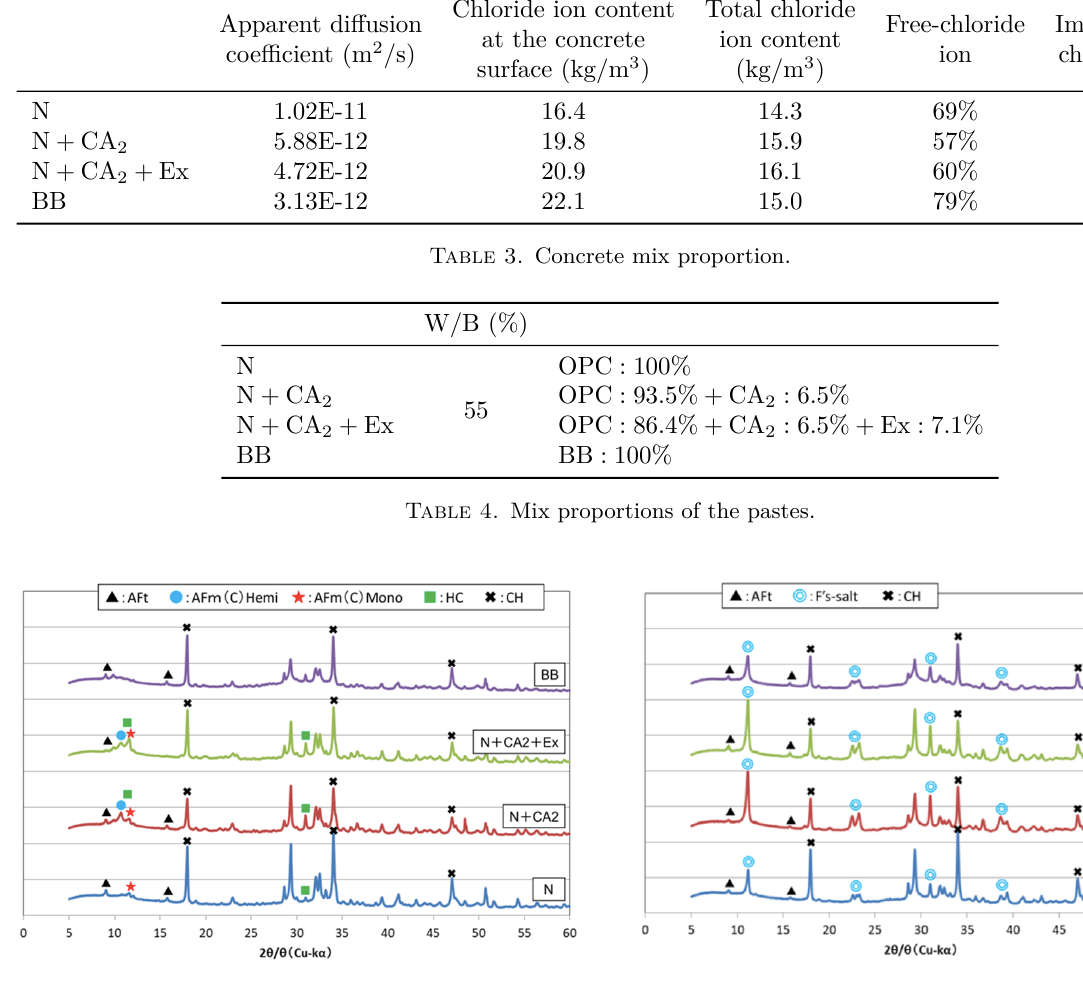
Figure 6. Hydrate before immersion. Figure 7. Hydrate before